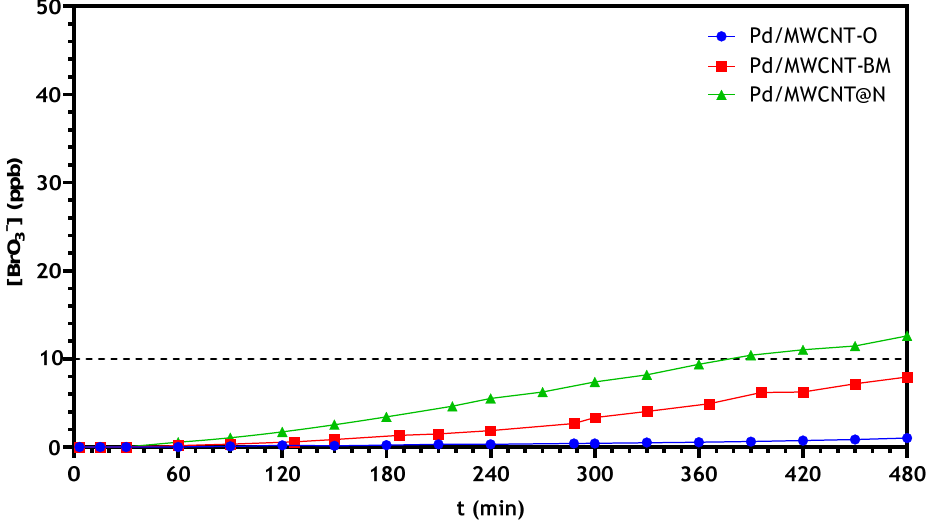
Figure 3. Bromate concentration (ppb) during continuous hydrogen reduction over the catalysts 1 wt.% Pd/MWCNT-O, 1 wt.% Pd/MWCNT@N and 1 wt.% Pd/MWCNT-BM mixed with 0.500 mm carborundum under H 2 . (Q = 5 mL min − 1 , 200 mg CAT , H 2 = 50 cm 3 min − 1 , C (BrO 3 − ) = 200 ppb).